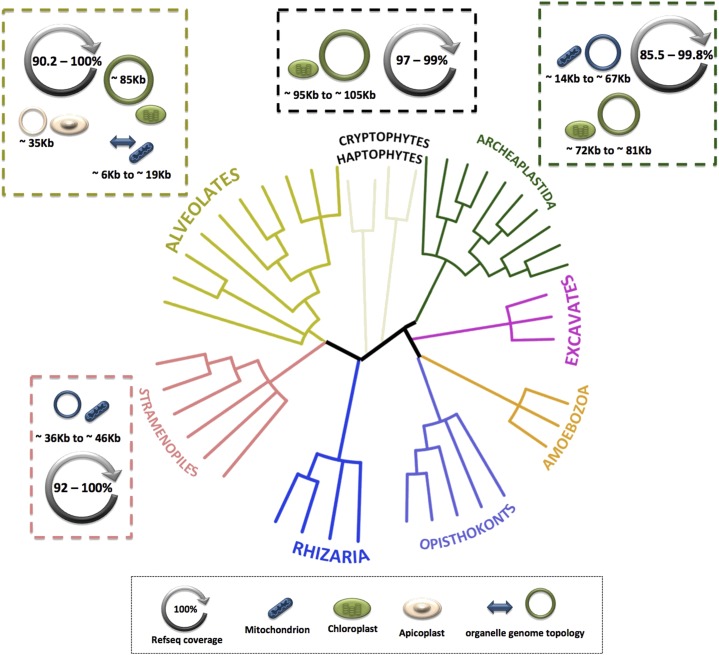
Pervasive organelle genome transcription across the eukaryotic tree of life. Organelle genomes ≤105 kb are fully or almost fully transcribed in diverse eukaryotic groups, regardless of their coding content and structure. Outer dashed boxes summarize the breadth of organelle genomes analyzed within each major eukaryotic group. Representation of organelle genomes and organelles are not to scale. Refseq coverage represents the percentage of the reference genome sequence that was covered by one or more RNA-seq reads in the mapping analyses. Phylogenetic tree is adapted from Burki (2014) for the relationships among major groups; branches within groups are merely illustrative and not based on sequence analyses. The tree was generated using the NCBI Common Tree taxonomy tool (Federhen 2012) and iTOL v3.4.3 (Letunic and Bork 2016).